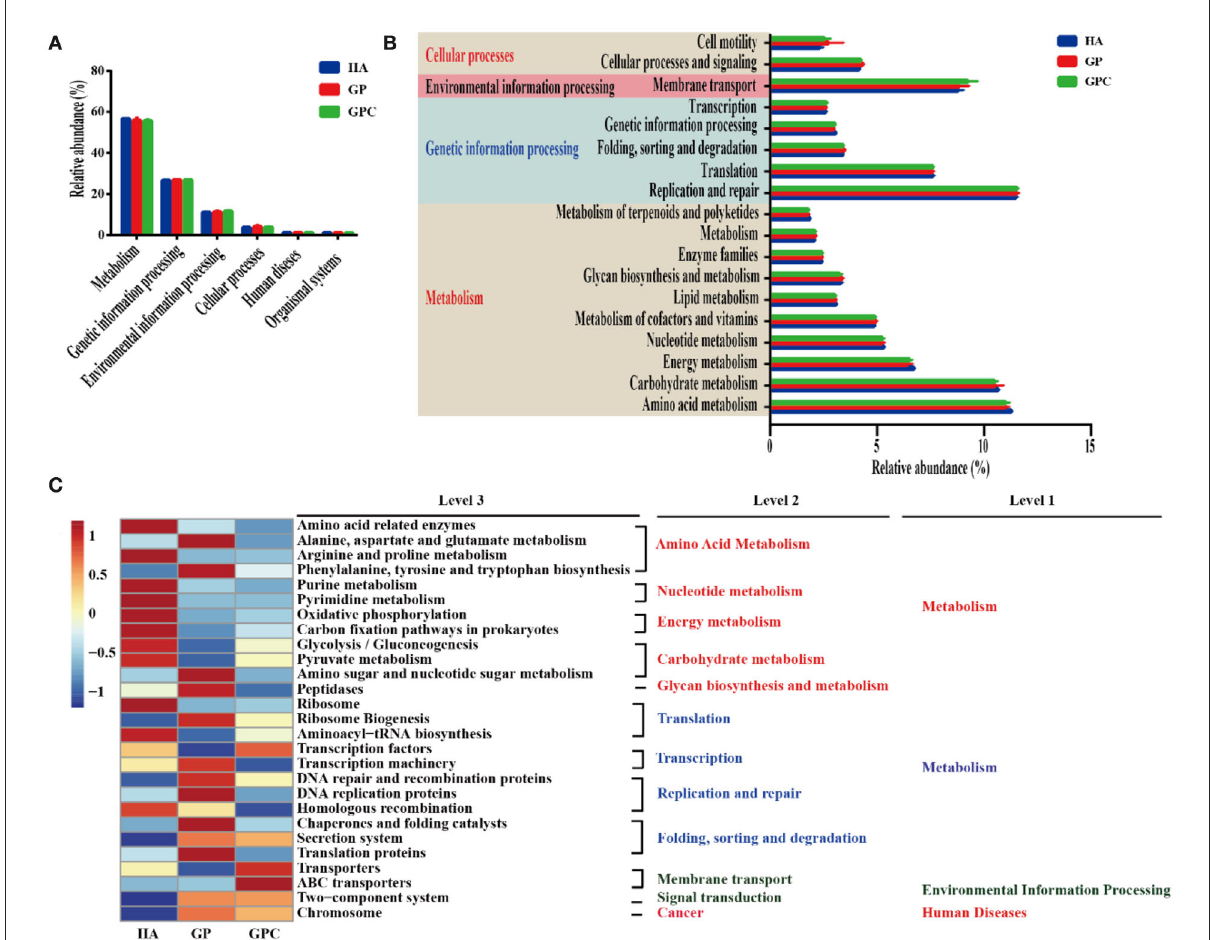
FIGURE5 Dynamics of rumen bacterial predicted functional profiles fed with different diets analyzed using PICRUSt ( n = 6). (A) Level 1 metabolic pathways. (B) Level 2 Kyoto Encyclopedia of Genes and Genomes (KEGG) ortholog functional predictions of the relative abundances of the top 20 metabolic functions. (C) Level 3 KEGG ortholog functional predictions of the relative abundances of the top 30 metabolic functions. HA, non-pelleted native grass hay diet, GP, pelleted native grass hay diet; and GPC, pelleted native grass hay with concentrate